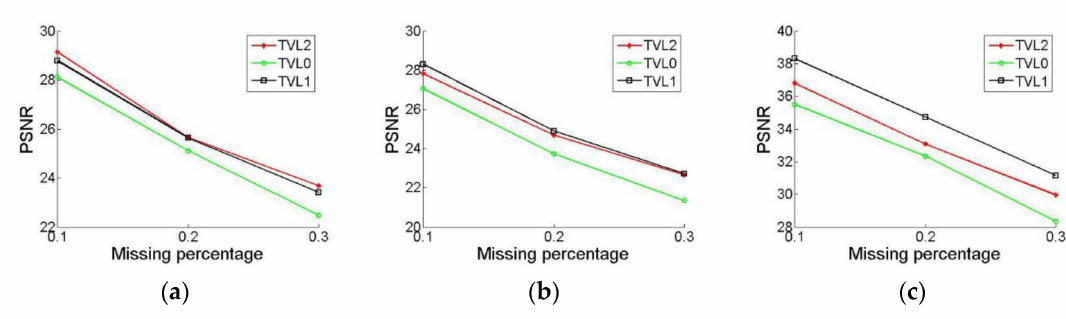
Figure 2. PSNR comparison against the severity of damages for three images. ( a ) Lenna. ( b ) Goldhill. ( c ) Synthetic.